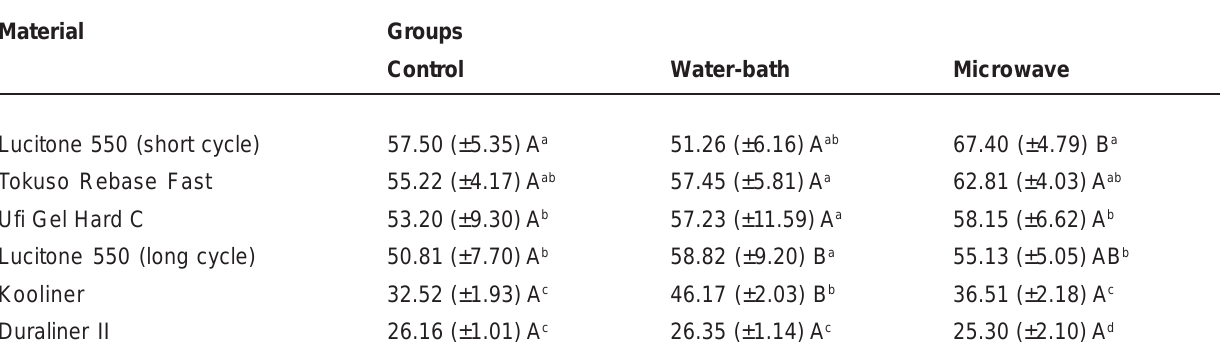
TABLE 2- Flexural strength means (MPa) (±standard deviation)